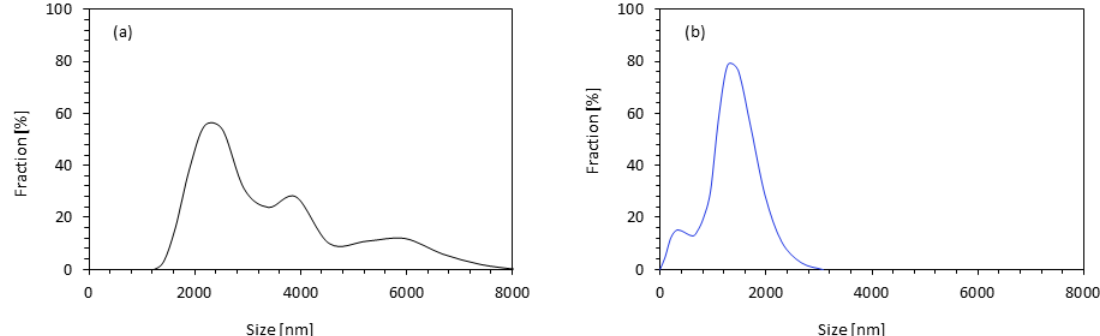
Figure 4. Particle-size distribution of ( a ) apricot filler and ( b ) casein/apricot filler.